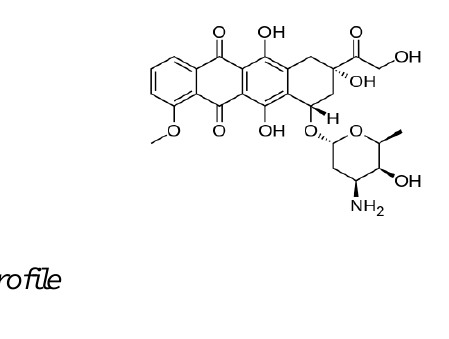
Figure 3. Chemical structure of doxorubicin (C